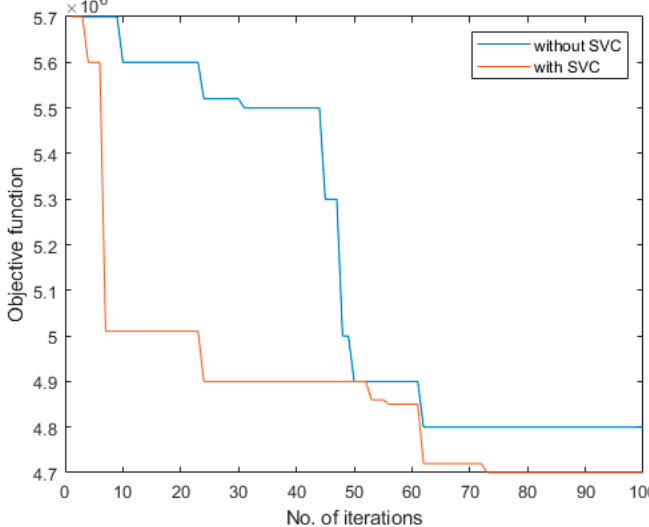
Figure 6. Convergence characteristics.